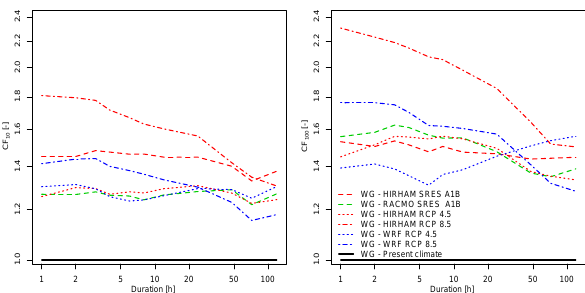
Figure 11. Climate factors for different return periods for the differ- ent perturbed WG runs. T = 10 years (left panel) and T = 100 years (right